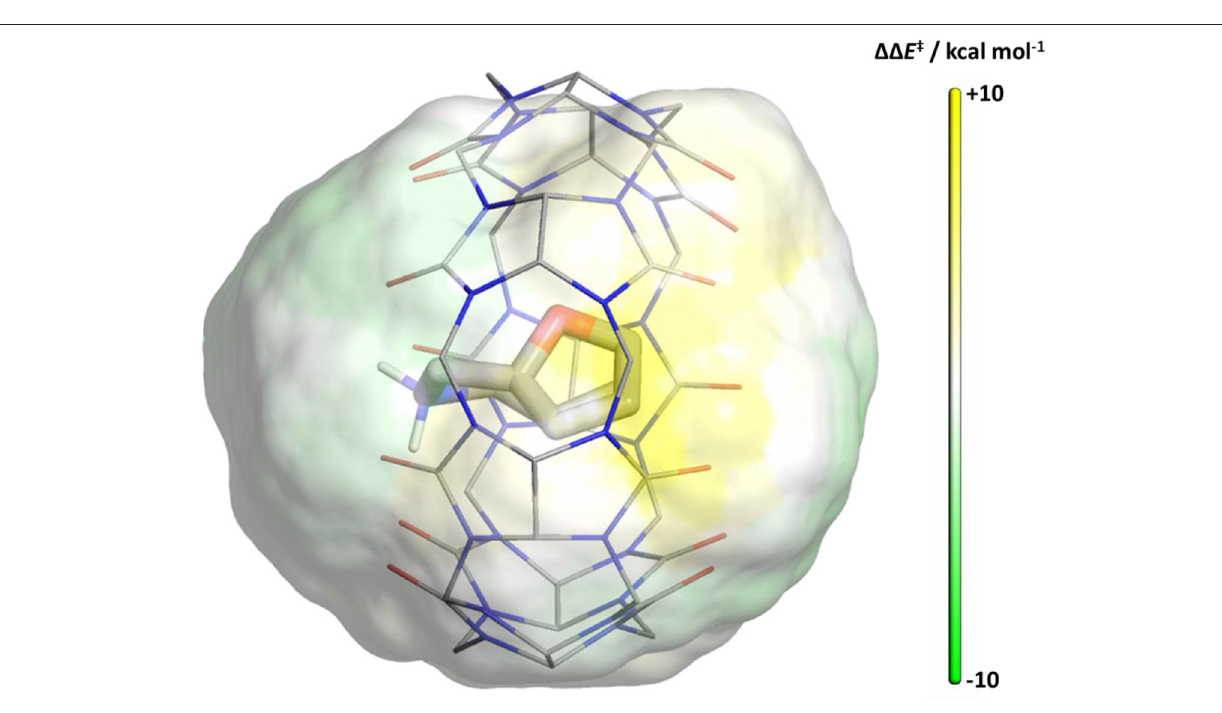
Frontiers in Chemistry |